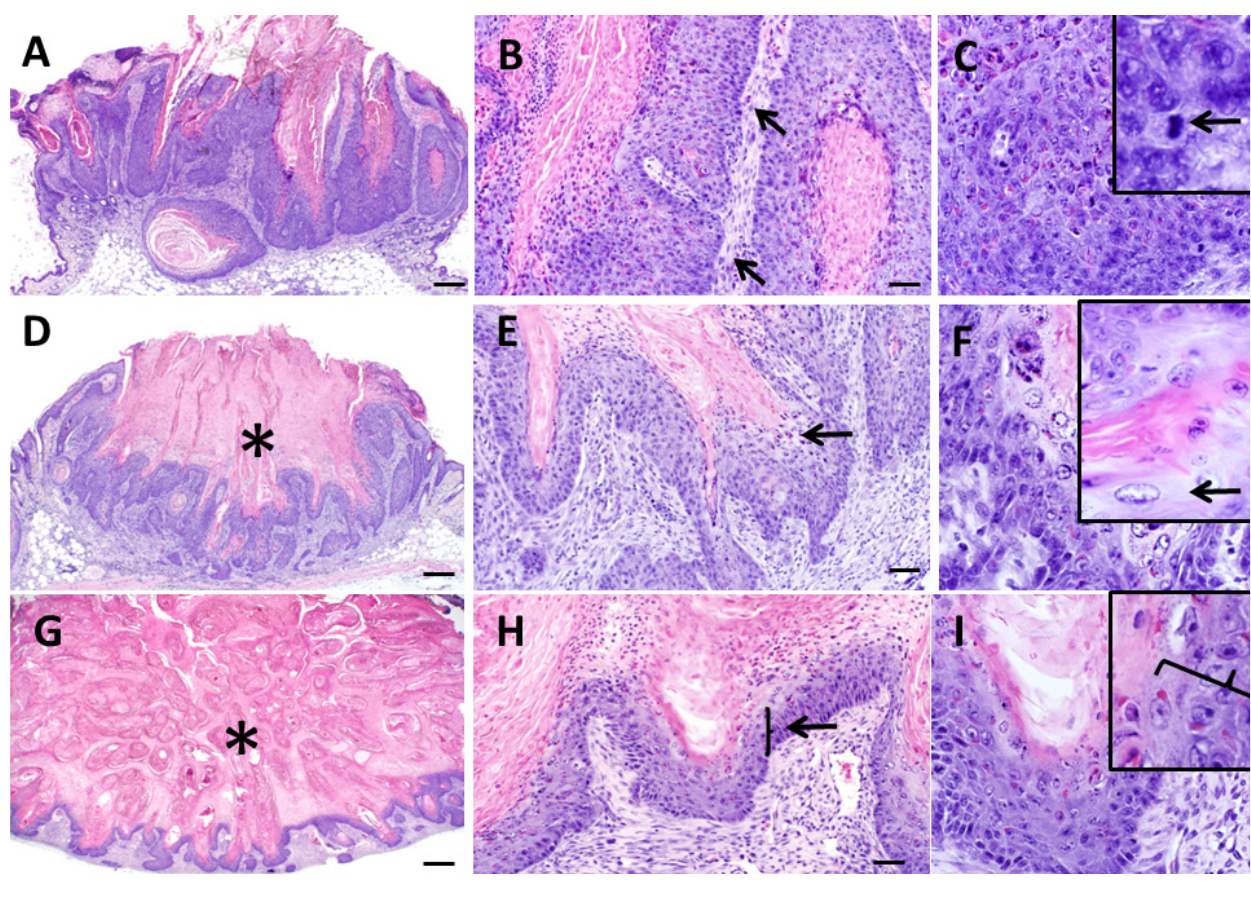
Figure 4. Histopathologic features of keratoacanthomas from Zimz1 mice. Keratoacanthomas (KAs) were classified into three separate groups based on their morphology on HE section. Those in the “growth” phase (G) ( A , B , C ) had keratin and inflammation (B, arrows), and were lined by a proliferative layer of keratinocytes which were poorly defined into distinct epidermal layers with anisocytosis and anisokaryosis along with multiple mitotic figures (C, arrows). Those in the “maturation” phase (M) ( D , E , F ) had a central crater of keratin (D, asterisk) and were lined by proliferative epithelium with patchy regions of “glassy cells” (E, F, arrows) and also had moderate dermal inflammation. Those in the regression phase (R) ( G , H , I ) had abundant keratin (G, asterisks) with noticeable thinning of the epithelial lining (H, I, arrow) and